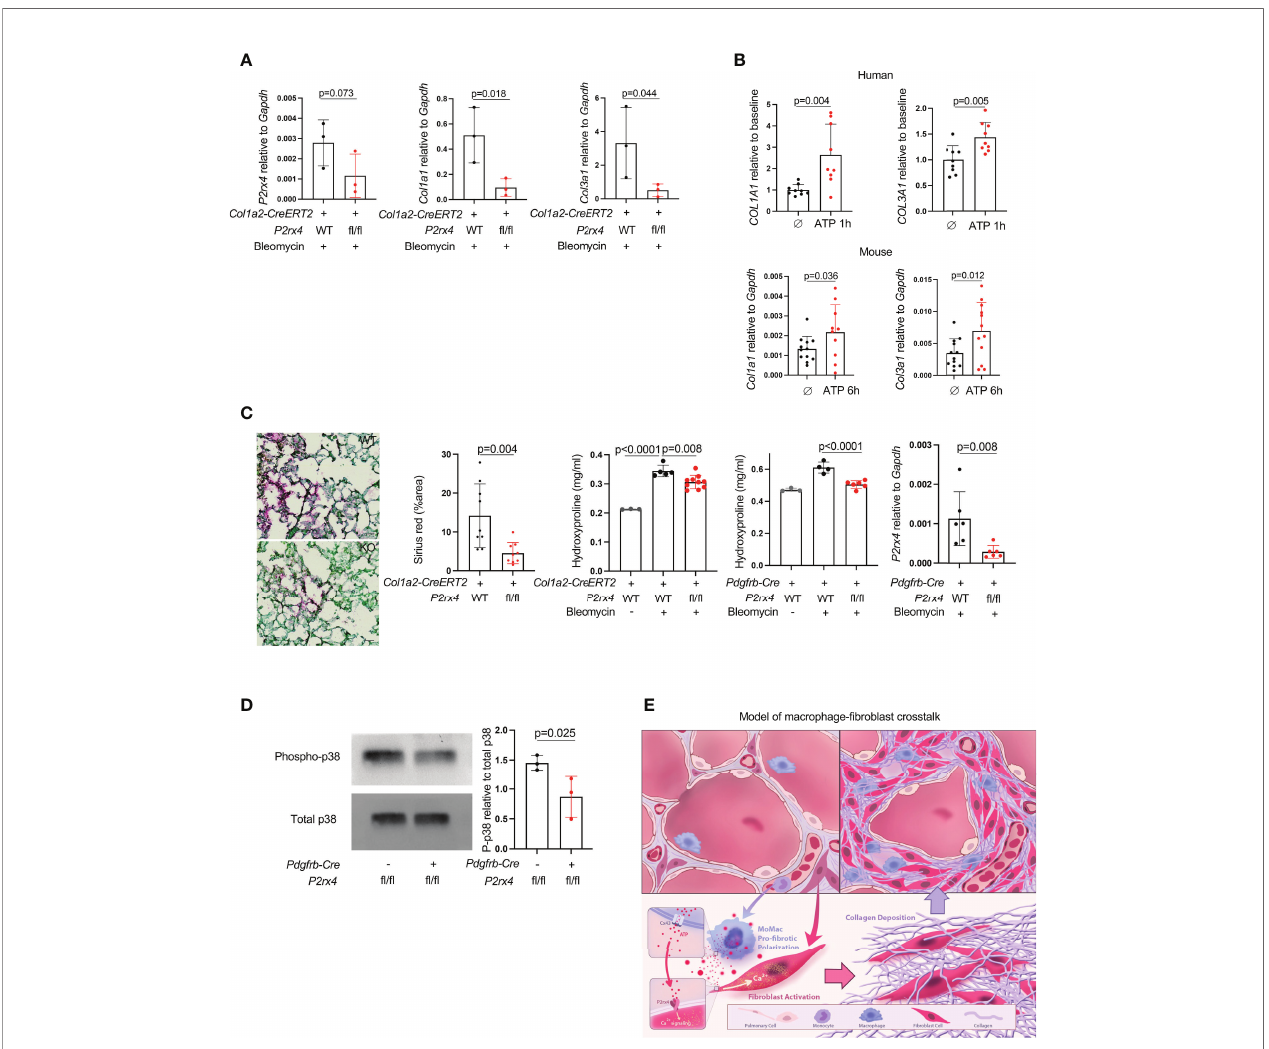
FIGURE 4 | P2rx4 is necessary for lung fi brosis. (A) qPCR for collagen genes and P2rx4 in primary mouse lung fi broblasts isolated from mice with fi broblast-speci fi c P2rx4 deletion. N=3 mice. P values are for unpaired one-tailed t-tests. (B) qPCR for collagen genes in human (upper) and mouse (lower) primary lung fi broblasts treated with ATP g S. N=3 separate individuals and n=3 separate mice. P values are for unpaired two-tailed t-tests. (C) Left: Sirius red staining of lungs at 21 days post bleomycin injury in Col1a2-CreERT2 : P2rx4 fl / fl or Col1a2-CreERT2 controls. Representative images are shown. Quanti fi cation is for n=3 mice. Scale bar=50 m m. P value is for unpaired two-tailed t-test. Right: Hydroxyproline assays of whole lung collagen from mice with fi broblast-speci fi c P2rx4 deletion with two different Cre drivers as indicated, and controls. N=3-10 as shown. P values are for one-way ANOVA followed by Sidak ’ s multiple comparison test. qPCR is for P2rx4 in fi broblasts isolated from Pdgfrb-Cre: P2rx4 fl / fl or Pdgfrb-Cre controls. N=6 mice in each group and P value is for Mann-Whitney test. (D) Western Blot of phospho-p38 and total p38 for fi broblasts isolated from Pdgfrb-Cre : P2rx4 fl / fl or Pdgfrb-Cre controls. Quanti fi cation shows the ratio of P-p38 to total p38 by densitometry. P value is shown for unpaired one-tailed t-test and n=3 mice. (E) Model of fi broblast activation by paracrine ATP derived from monocyte-derived macrophages in lung fi